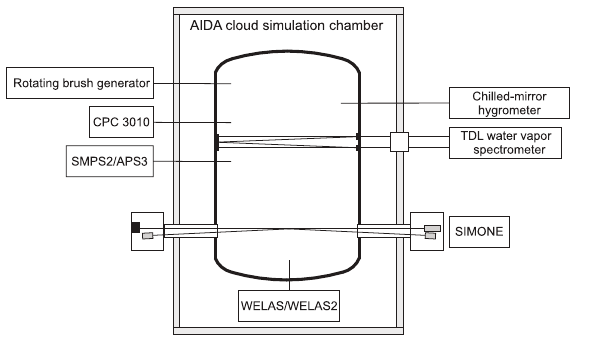
Figure 1. Schematic drawing of the AIDA cloud chamber: aerosol instrumentation (rotating brush generator, APS, SMPS, CPC3010), instruments used for characterization of the droplet/ice crystal population (welas/welas2, SIMONE) and humidity measurements (TDL, chilled-mirror hygrometer).